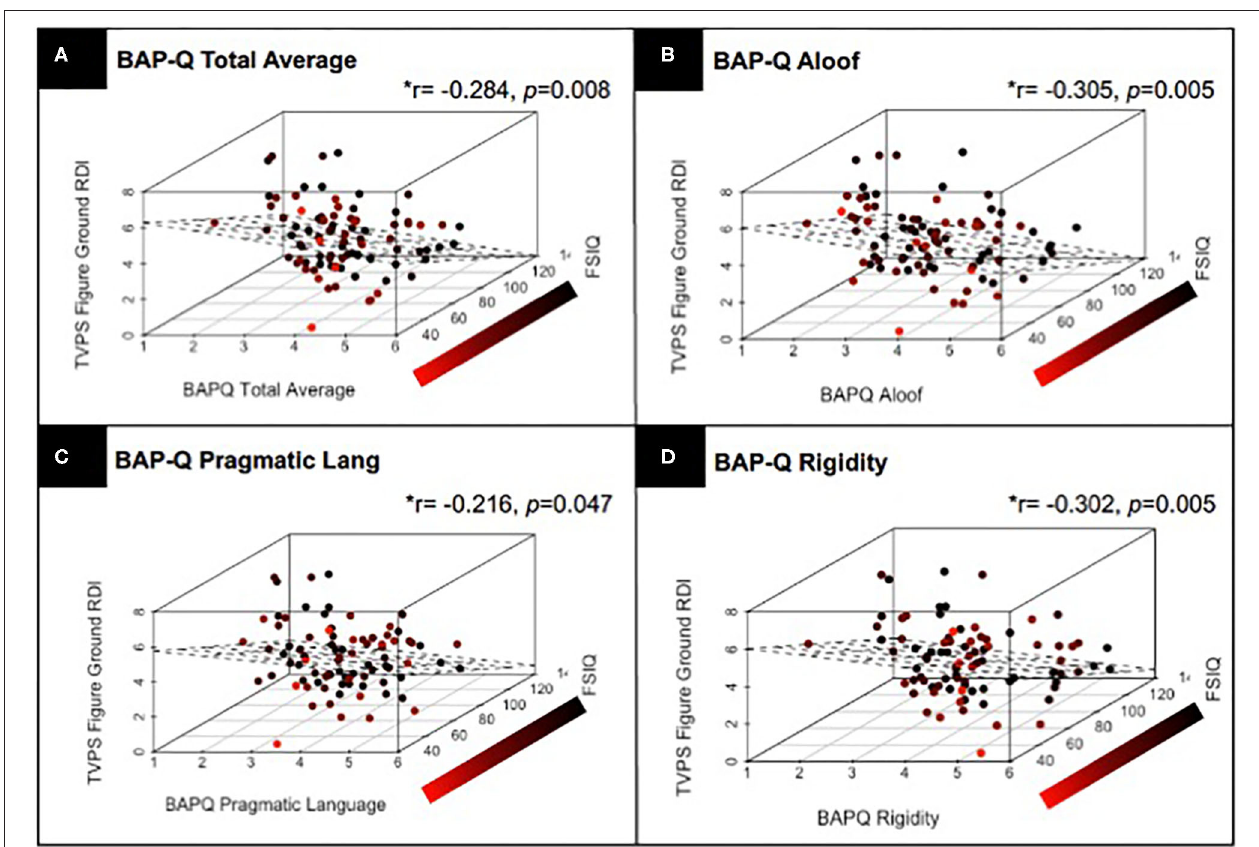
FIGURE 4 | Results from a partial correlation (FSIQ) with correction for multiple comparisons, across children with and without ASD, demonstrating the relationship between TVPS-FG RDI scores and (A) BAP-Q Total scores; (B) BAP-Q Aloof subscales scores; (C) BAP-Q Pragmatic Language Scores; and (D) BAP-Q Rigidity subscale scores. Linear planes represent the results of a linear regression using FSIQ and (A) BAP-Q Total scores as well as (B–D) BAP-Q Aloof, Pragmatic Language, and Rigidity subscale scores to predict TVPS-FG subtest scores across children with and without